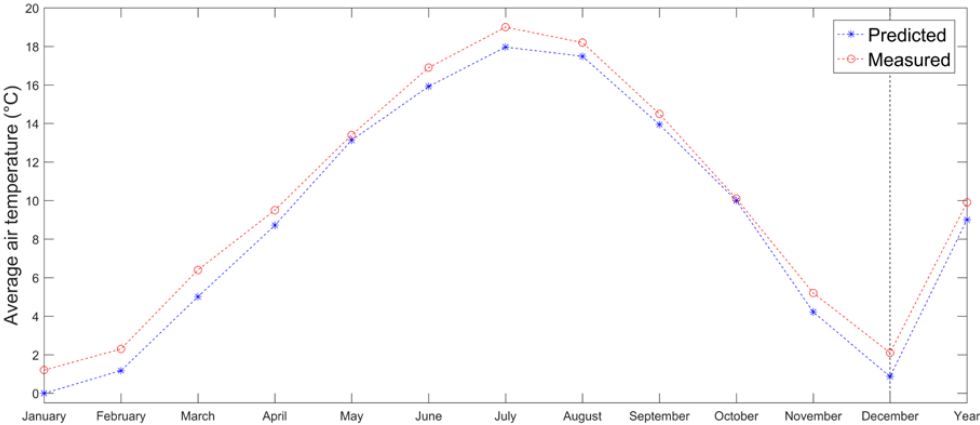
Figure 9. Estimated and measured monthly average air temperatures for Acquarossa (Switzerland) meteorological station using monthly lapse rates.